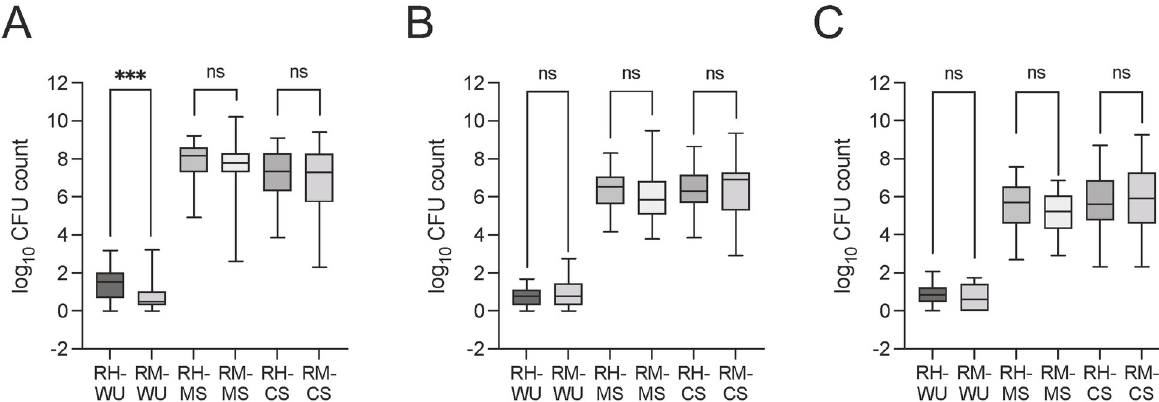
Fig 1. The abundance of total E . coli and antibiotic-resistant E . coli in water and stool samples from mothers and children in Hajiganj and Matlab. The number of A) total E . coli , B) third-generation cephalosporin-resistant E . coli , and C) fluoroquinolone-resistant E . coli in drinking water (WU), mother stool (MS), and child stool (CS) samples collected from the Hajiganj (RH, high arsenic exposure) and Matlab (RM, low arsenic exposure) areas were counted from the plates for each of the samples as described in the Methods section. The numbers were calculated as either CFU/100ml for water samples or CFU/g for MS and CS samples and transformed to log 10 count. Each box represents the first and third quartile number of E . coli (log 10 transformed) for one type of sample with the black bars representing the median count and error bars representing the minimum and maximum range of the counts, respectively. The asterisks indicate significance ( ��� p < 0.001). ‘ns’ indicates not significant.